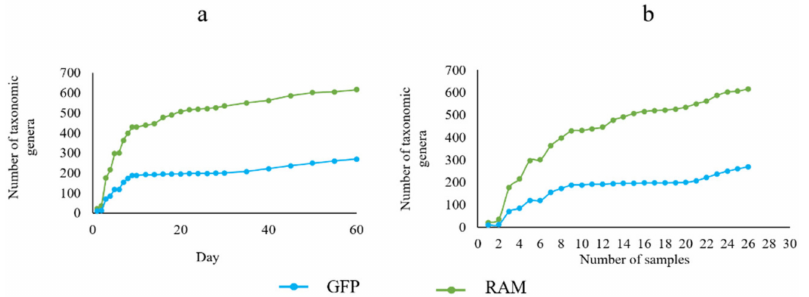
Figure 6. ( a ) The trend of the number of dormant bacteria species with the monitoring time; ( b ) The trend of the number of dormant bacteria species with sampling times.